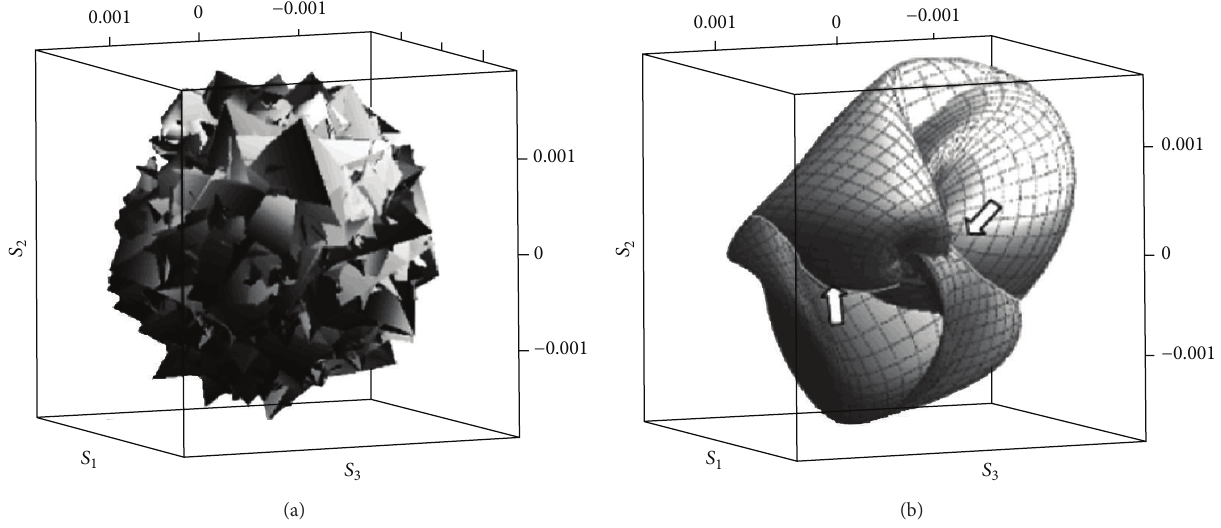
Figure 5: The initial (a) and final after 250th iteration (b) phase states in the absence of an external shear field.